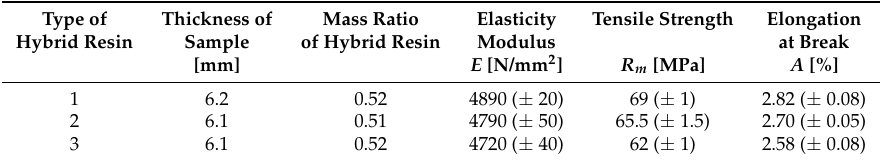
Table 6. The mean value with the standard deviation for elasticity modulus, tensile strength and elongation at break for composites with matrix of hybrid resin of type 1, 2 and 3, reinforced with second type of flax